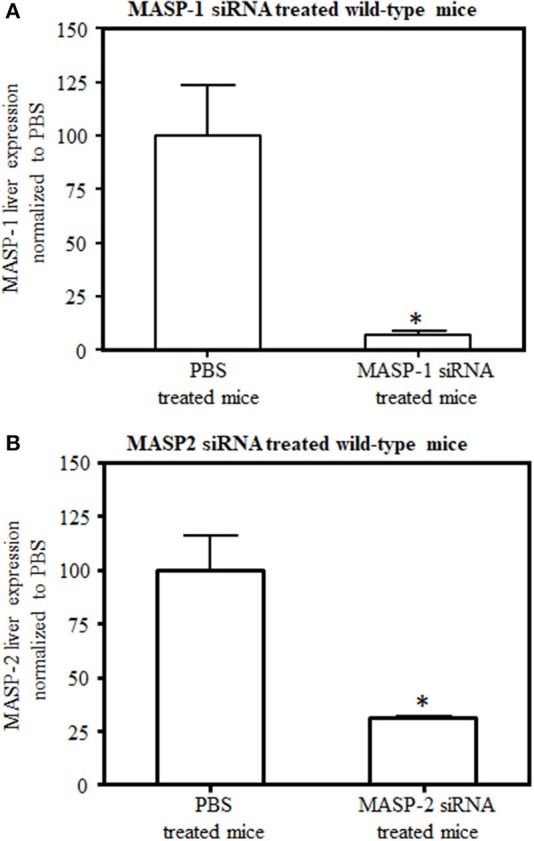
Comparing levels of (A) MASP-1 and (B) MASP-2 expression by qRT-PCR in C57Bl/6J mice liver. Liver mRNA was extracted at day 7 after mice were injected with either GalNAc–MASP-1–siRNA or GalNAc-MASP2-siRNA or PBS. Gene expression was examined using qRT-PCR. GAPDH expression was used as an internal control to calculate the expression of MASP-1 or MASP-2. Data shown as mean and SEM of three replicates. The p-values were calculated using t-test. *p < 0.05 vs. PBS.